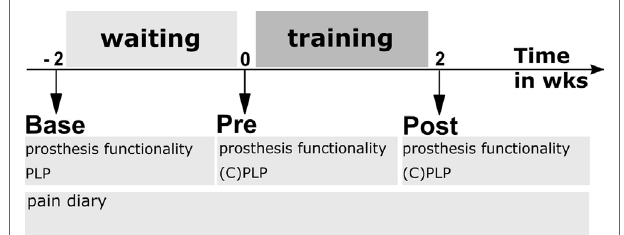
FigUre 1 | Experimental design. Base—baseline assessment; Pre— assessment directly before first training session; and Post—assessment after last training session. Waiting period—patients used their own cosmetic prosthesis without feedback during everyday life. Training period—patients used their own prosthesis that was equipped with a somatosensory feedback system during 10 days of prosthesis training. Prosthesis functionality was assessed using questionnaires and walking tests, PLP—phantom limb pain characteristics, CPLP—retrospective change of PLP during past 2 weeks.